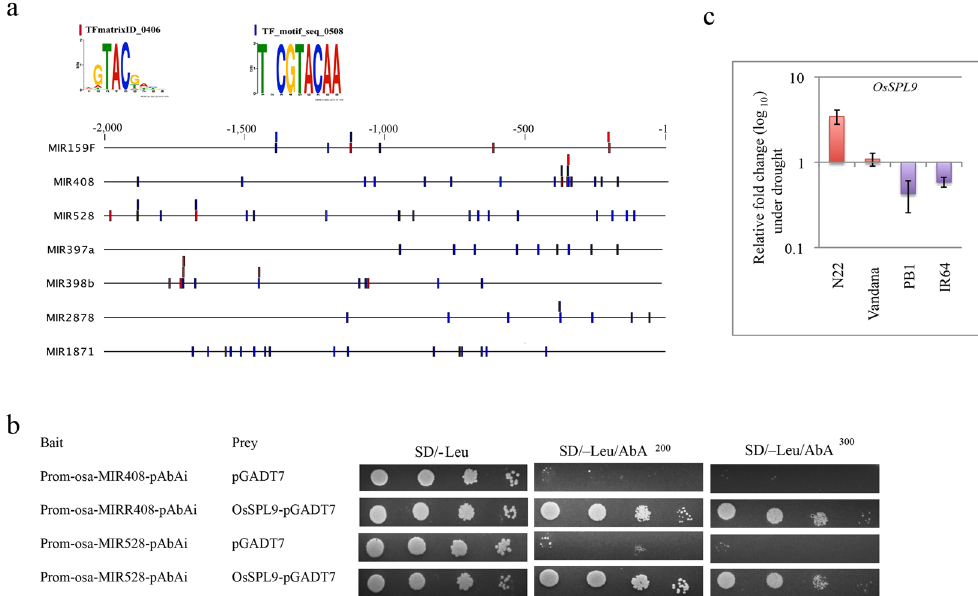
Figure 5. OsSPL9 mediated regulation of CSDR-miRNAs ( a ) The representation of OsSPL9 binding sites on the 2 kb promoter of CSDR-miRNAs. ( b ) Y1H assay of binding of OsSPL9 to the promoter sequence of MIR408 and MIR528. Yeast cells were grown on selective media with different concentrations of 3-amino-1,2,4-trizole (3-AT). ( c ) Real-time expression analysis of OsSPL9 in flag leaf of N22, Vandana, PB1 and IR64 under field drought conditions simulated at heading stage of development. Three biological replicates were analyzed with three technical repeats. Error bars represent the standard